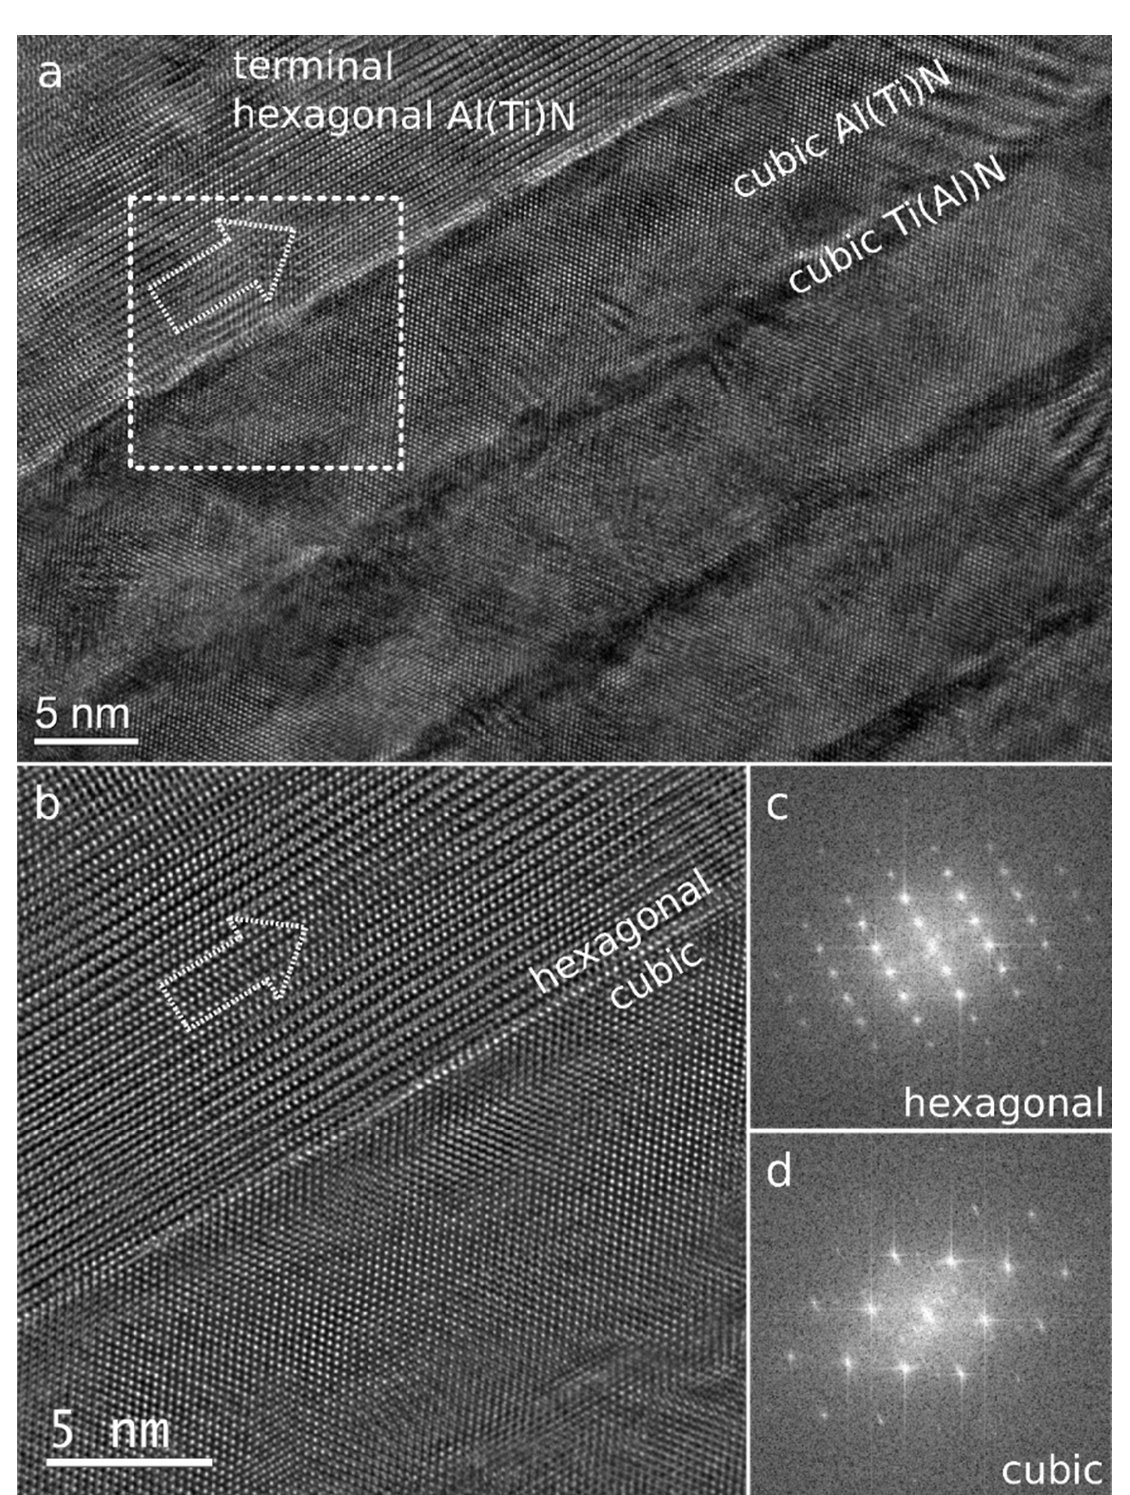
Figure 7. High-resolution TEM (HR-TEM) micrograph ( a ) showing an interface between a cubic Ti(Al)N/Al(Ti)N nanolamella stack and the terminating hexagonal Al-rich nanolayer (indicated by dotted outline arrows). The inverse FFT filtered HR-TEM micrograph ( b ) obtained from the dashed region in ( a ) documents an abrupt switch in crystal structure from cubic to hexagonal, as documented also by the FFTs from the respective cubic ( c ) and hexagonal ( d ) regions.